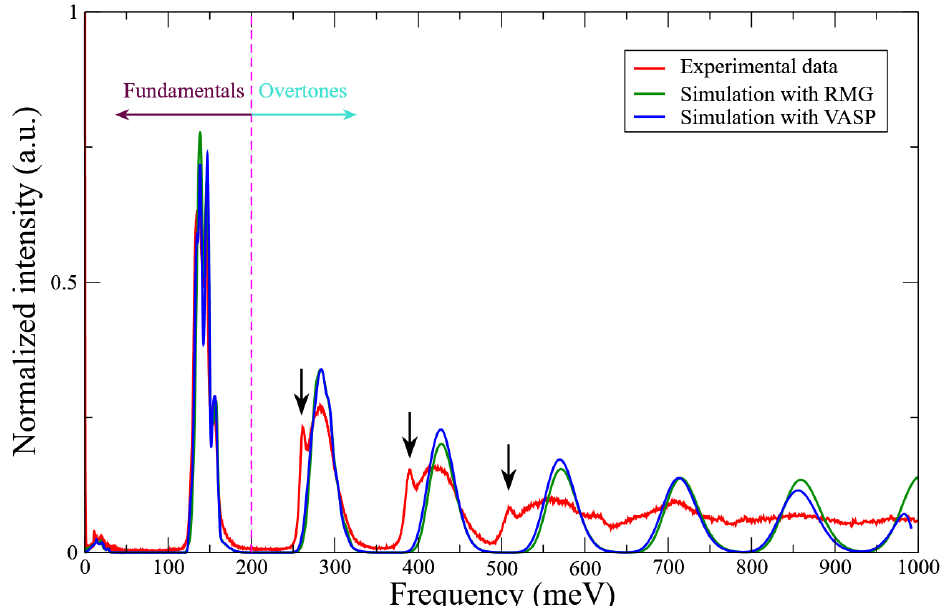
Figure 3. The VISION INS spectrum (red) at 5 K and the simulated spectra with RMG (green) and VASP (blue) at 0 K for (cid:15) -ZrH 2 . Spectra are normalized with respect to their area under the fundamental curve. Black arrows are marking peaks resulting from anharmonic effects (split peaks), which do not exist in the simulated spectra in the harmonic